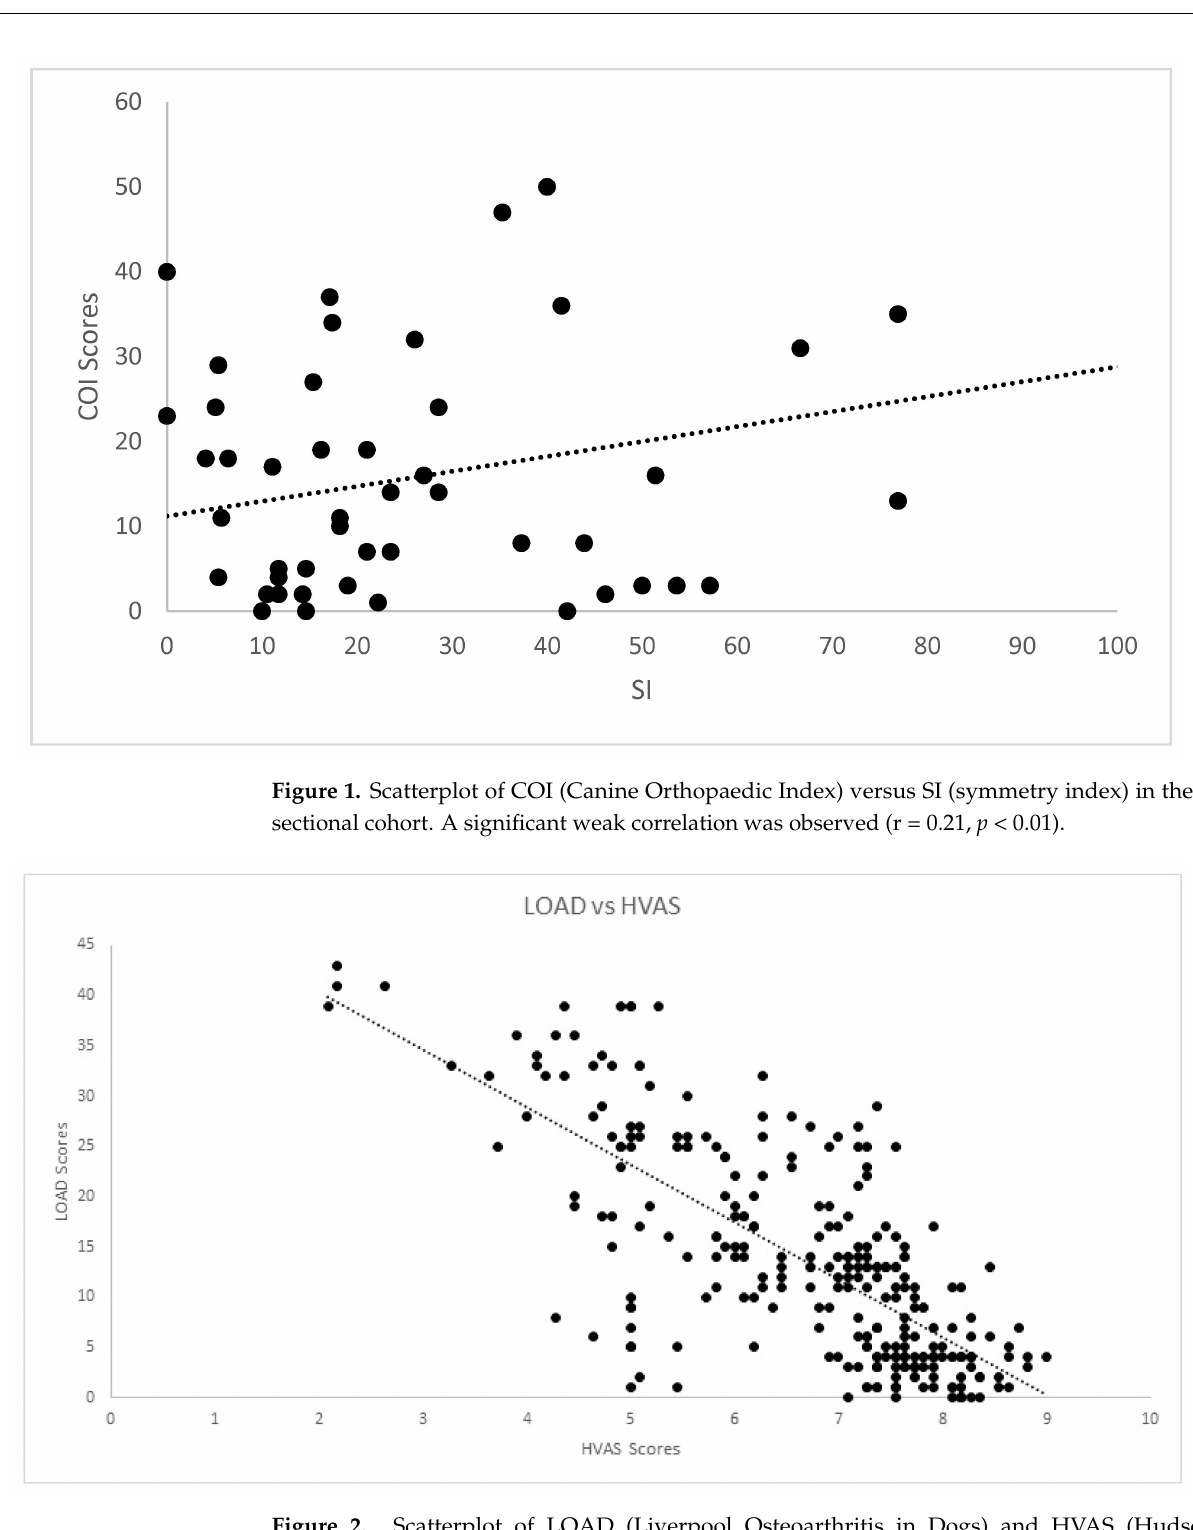
Figure 2. Scatterplot of LOAD (Liverpool Osteoarthritis in Dogs) and HVAS (Hudson Vi- sual Analogue Scale) in the longitudinal cohort. A significant strong correlation was observed (r = − 0.736, p <